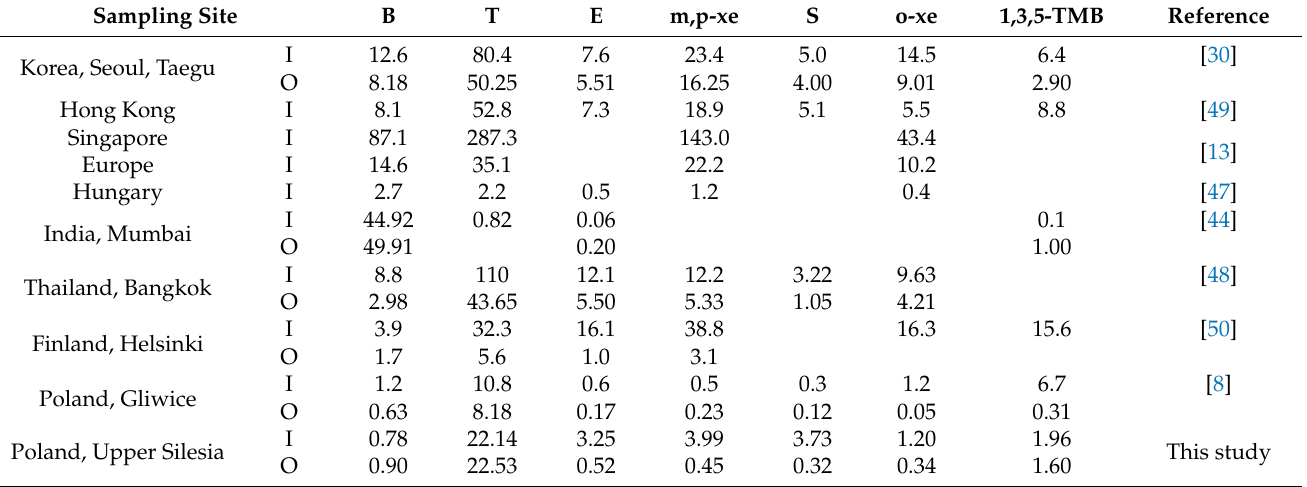
Table 4. Occurrence of benzene (B), toluene (T), ethylbenzene (E), styrene (S), xylenes (Xe), 1,3,5-trimethylbenzene (1,3,5- TMB)—in indoor (I) and outdoor (O), µ g/m 3 other various offices in the world. Sampling